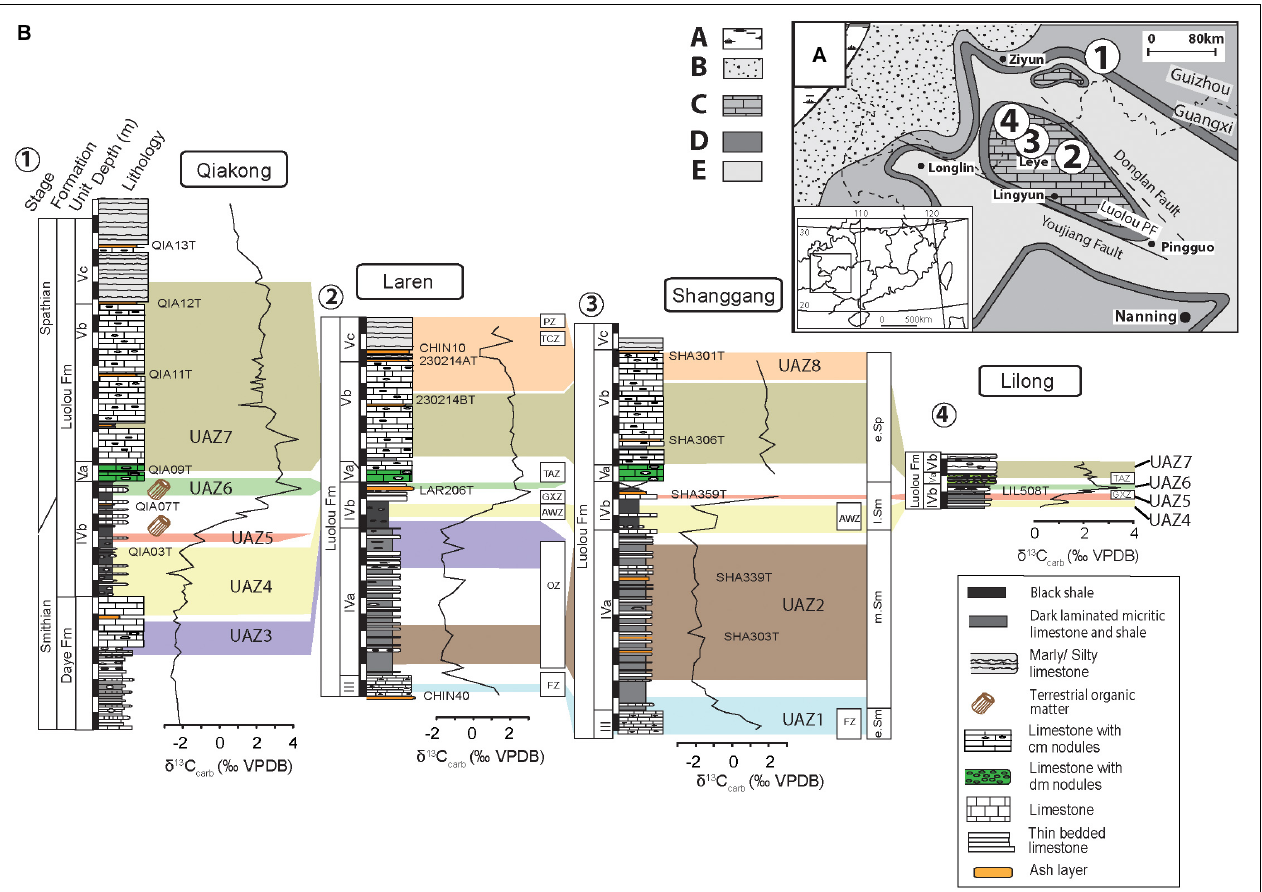
FIGURE 1 | (A) Early Triassic paleogeographic map of the Nanpanjiang Basin (modified from Bagherpour et al., 2017). A- alluvial facies, B-shallow-water siliciclastics, C-carbonate platform, D- slope, and E-basin. Studied sections: 1 – Qiakong, 2 – Laren, 3 – Shanggang, and 4 – Lilong. (B) Sections with position and sample numbers of dated ash layers and carbonate carbon isotope records ( δ 13 C data in Supplementary Table S3 ). Lithological units modified from Galfetti et al. (2008). Biostratigraphic age controls include ammonoid zones (white rectangles) and conodont Unitary Association zones (UAZ, colored; see on line material for further